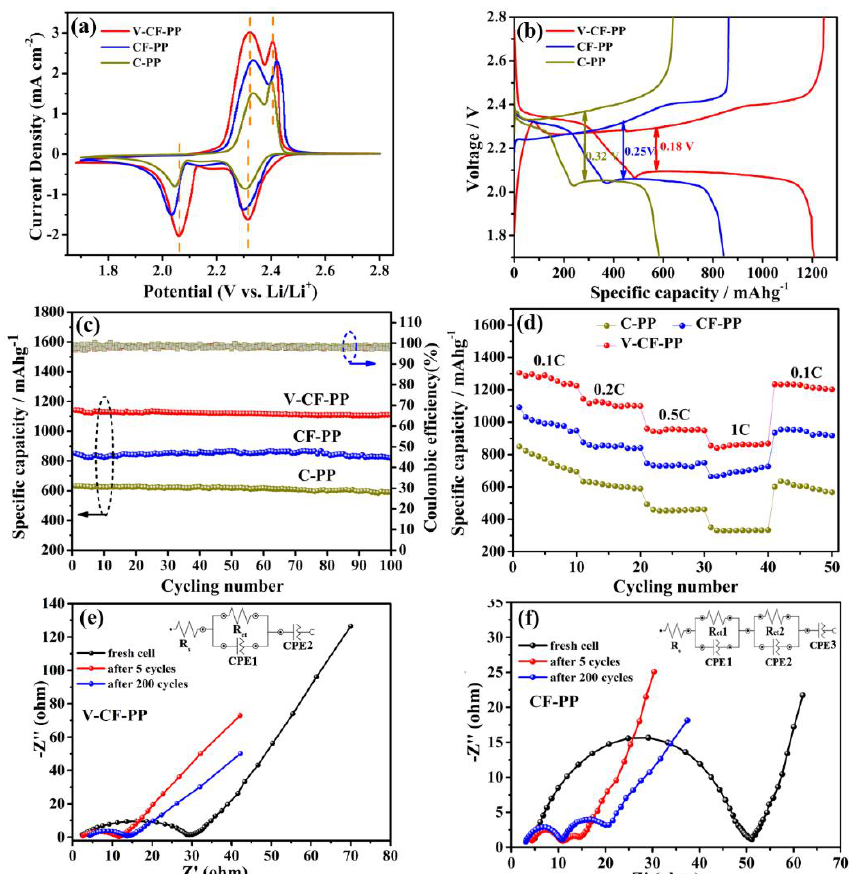
Figure 4. Electrochemical characterizations for the assembled batteries with PP, CF modified PP, and V-CF modified PP as the separators. ( a ) The second cycle cyclic voltammetry (CV) curves measured at a scan rate of 0.1 mV·s −1 . ( b ) The charge/discharge profiles measured at a current rate of 0.2 C. ( c ) The capacity and coulombic efficiencies versus the cycle numbers measured at a current rate of 0.2 C. ( d ) The rate performance for different cells measured at 0.1, 0.2, 0.5, and 1 C, respectively. ( e ) and ( f ) are the electrochemical impedance spectroscopy (EIS) plots for the CF-PP and the V-CF-PP cells, respectively, measured at different cycles. (The inset of figure shows the equivalent circuit diagram of the CF-PP and V-CF-PP after 200 cycles.).